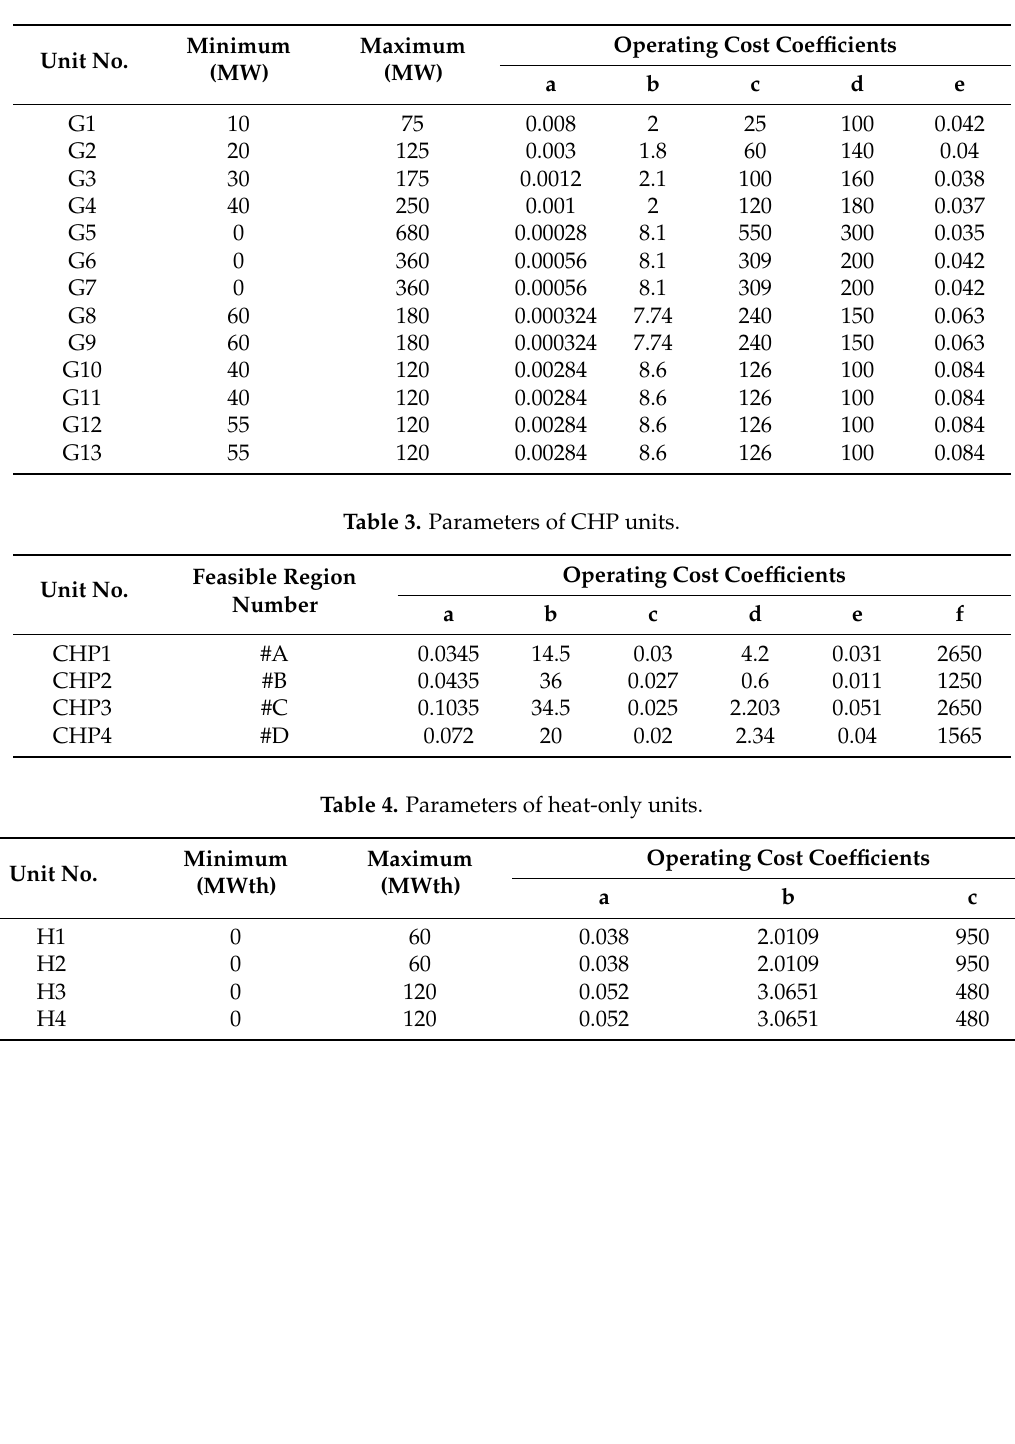
Table 2. Parameters of thermal units.